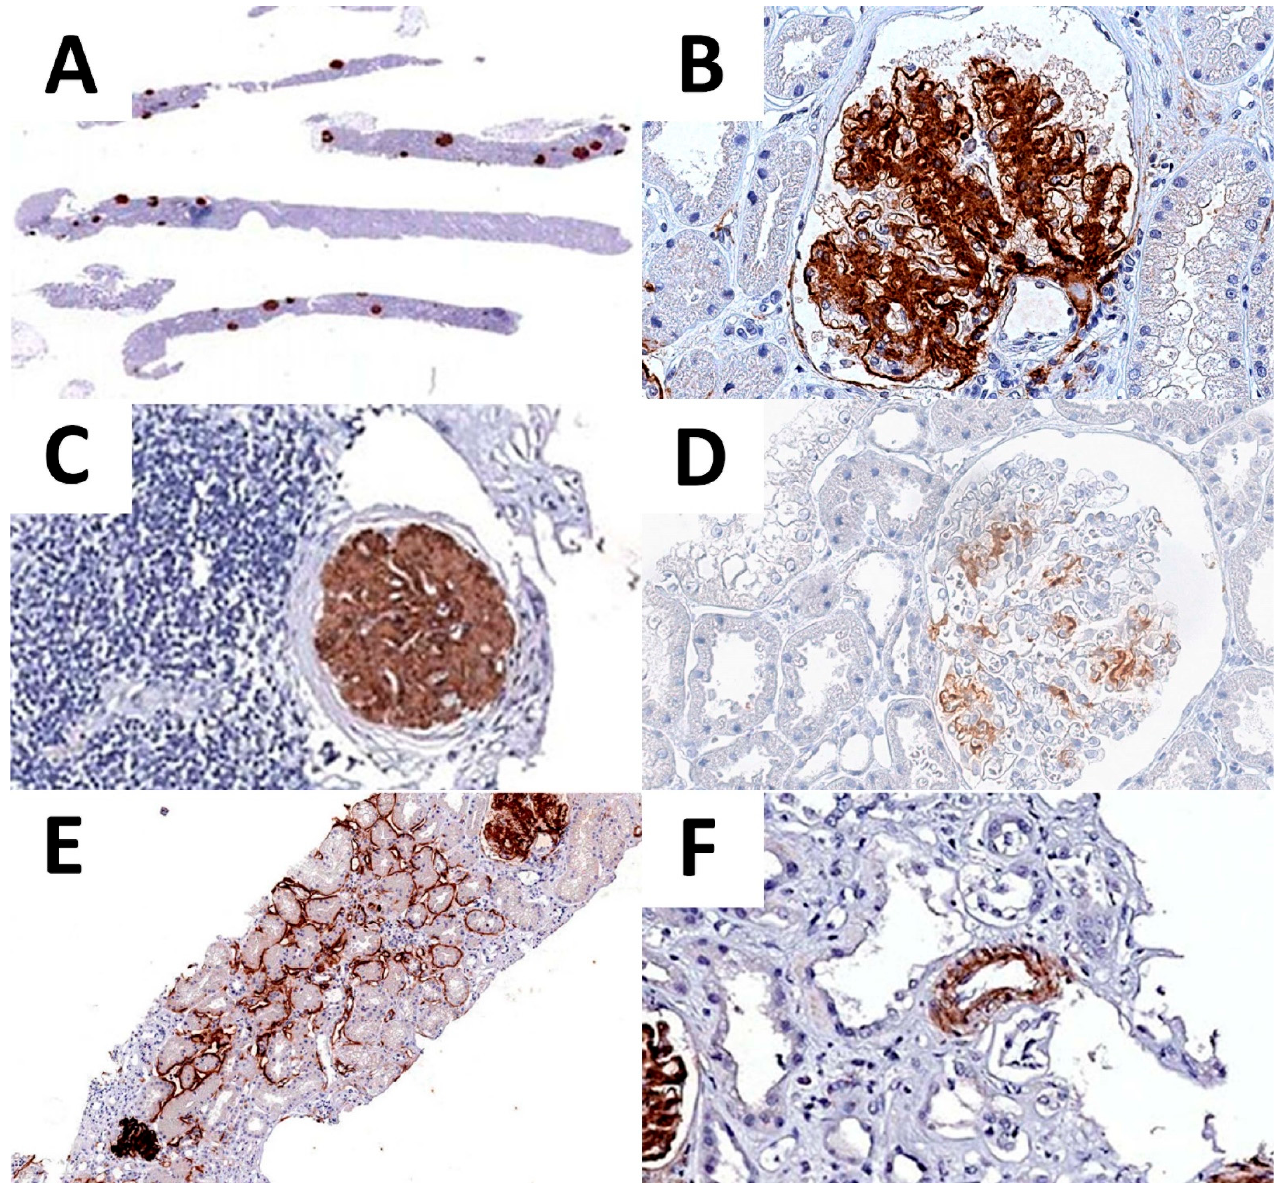
Figure 3. DNAJB9 IHC expression. DNAJB9 glomeruli positivity is recognizable already at low-power magnification ( A ). High-power image of DNAJB9 expression, showing a neat glomerular expression pattern ( B ). DNAJB9 expression is conserved in the glomeruli with intense periglomerular inflammation ( C ). Moderate and scattered DNAJB9 positivity in one of the early-stage FGN cases ( D ). DNAJB9 tubular ( E ) and vascular ( F ) expression.